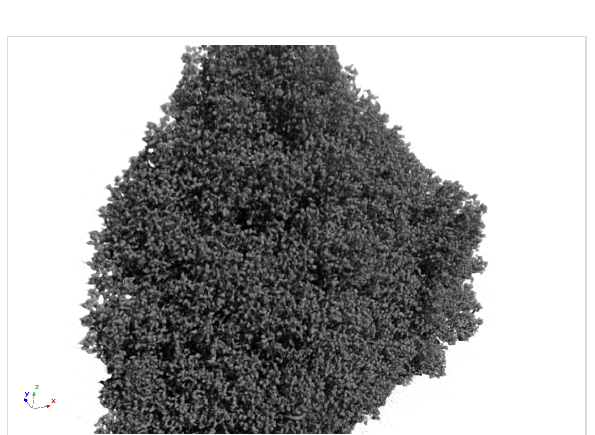
Figure 6: X-ray tomography 3D-reconstruction image of MonoBor [133]. Unpublished image from the authors.